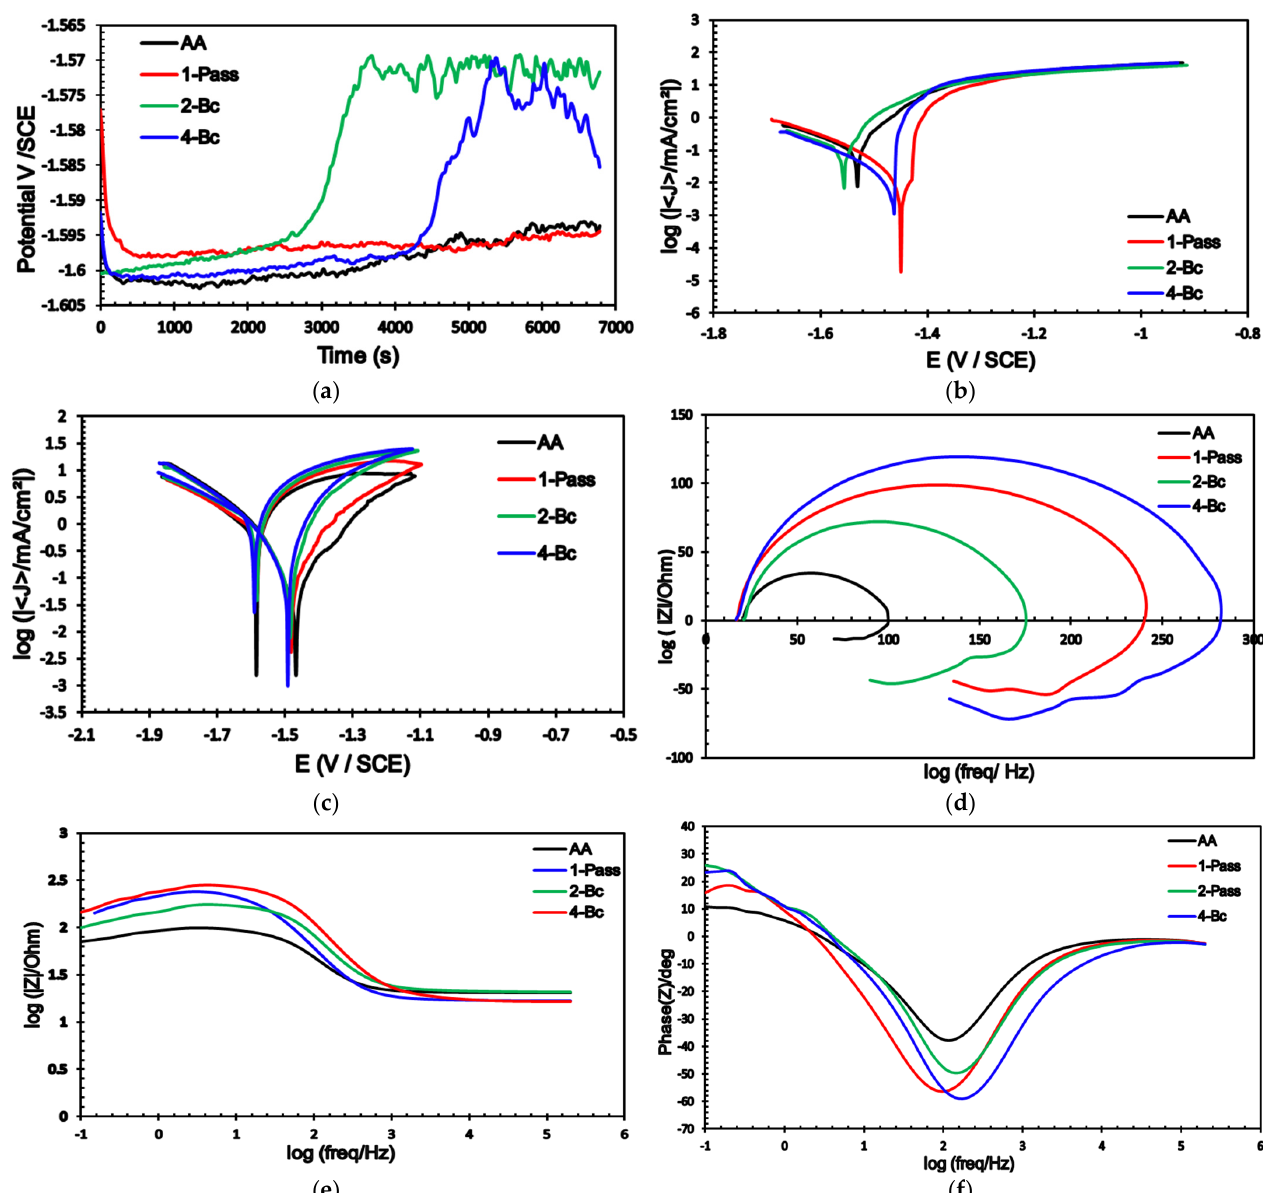
Figure 12. Corrosion measurements ( a ) OCP curves, ( b ) potentiodynamic polarization curves, ( c ) cyclic potentiodynamic polarization, ( d ) Nyquist plot, ( e ) Bode plot, and ( f ) Bode plot’s phase angle of ZK30 alloy using 3.5% NaCl solution.